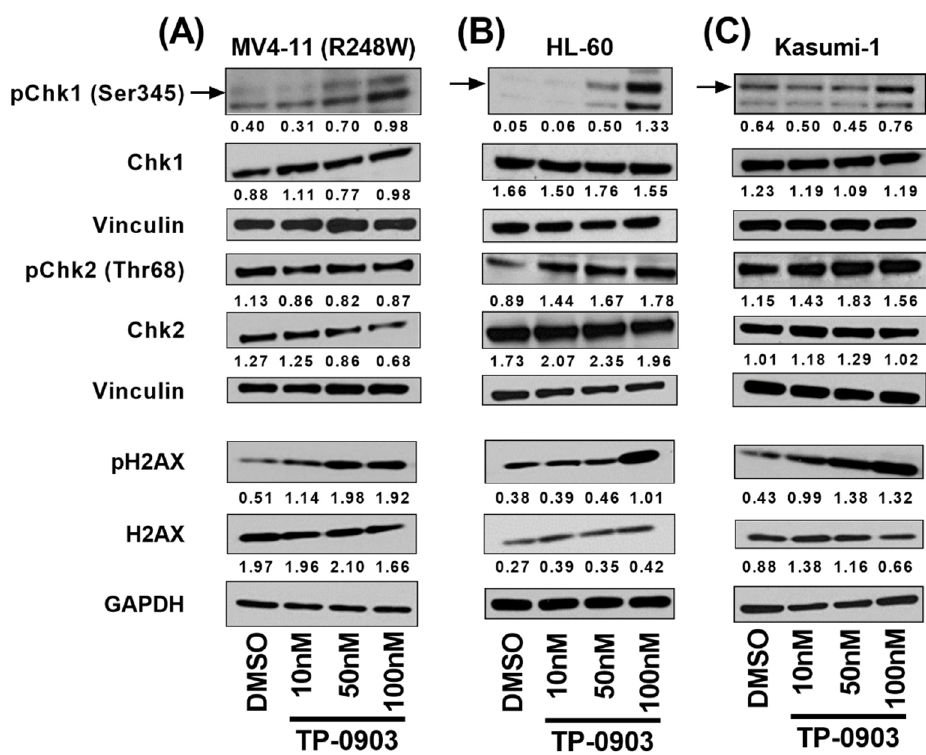
Figure 3. TP-0903 induces DNA damage response in TP53 mutant AML cell lines. ( A ) MV4-11 (R248W), ( B ) HL-60, and ( C ) Kasumi-1 cells were treated with DMSO or TP-0903 at indicated concentrations for 4 h. Immunoblotting was performed to determine the expression of pChk1 (Ser345), pChk2 (Thr68), and pH2AX (Ser139/Tyr142). Vinculin served as the loading control for pChk1/Chk1 and pChk2/Chk2 blots. GAPDH served as the loading control for pH2AX/H2AX blots. Immunoblots were quantified against respective loading controls (vinculin or GAPDH) using ImageJ. Blots are representative of 2–3 independent experiments.